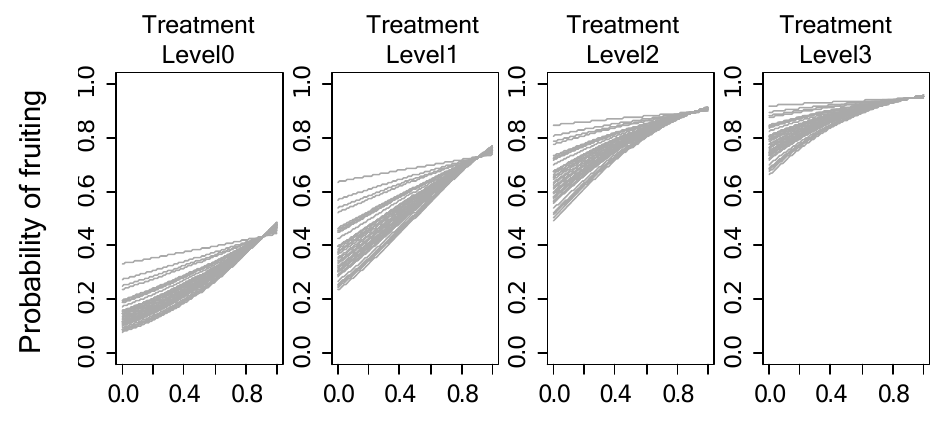
Figure 3. Genotype-specific relationship between fruiting probability and light intensity (relative photosynthetic photon flux density) across different girdling treatment levels. Each gray line indicates each L . kaempferi genotype (clone).